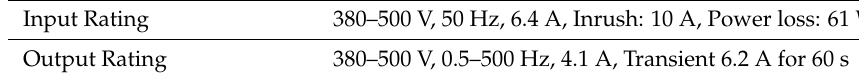
Table A2. VSD technical